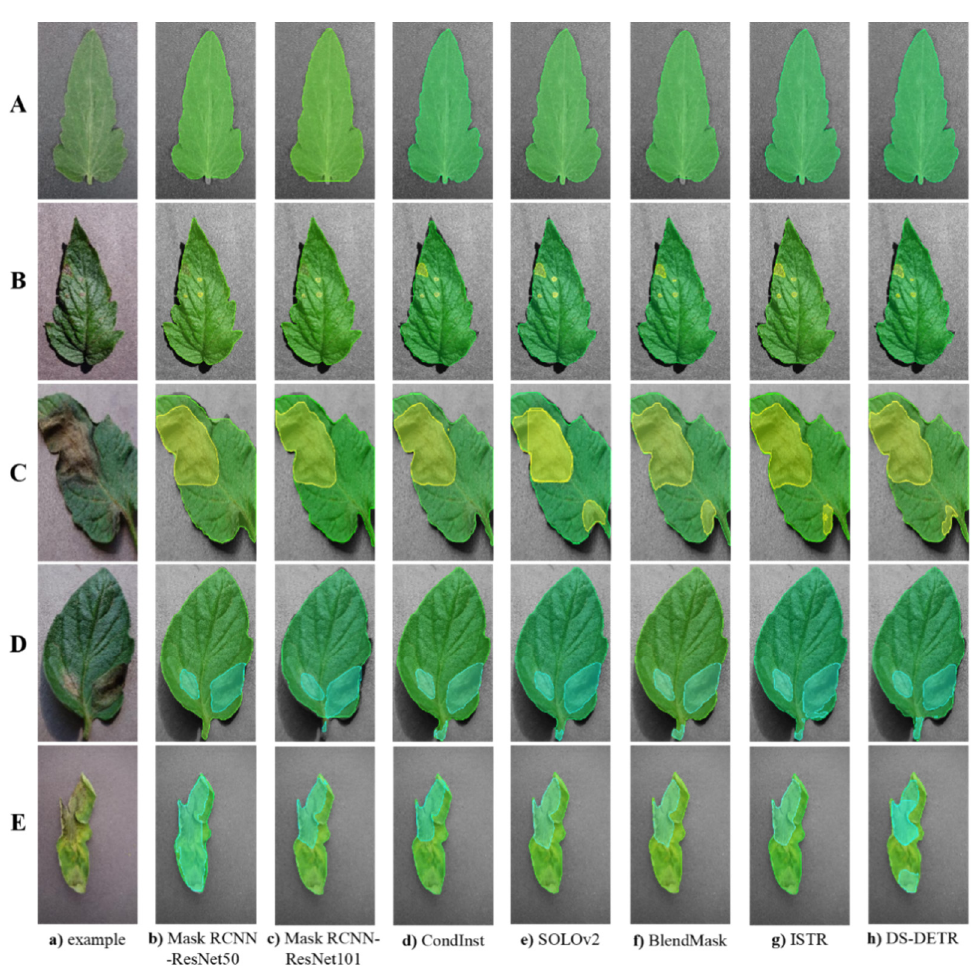
Figure 7. Segmentation effect visualization results. ( A – E ) are used to represent the grouping index numbers of the five samples we selected and their results respectively. Table 2. Average precision bounding boxes (AP box ), average precision segmentation (AP mask ), runtime per image, and model parameter of instance segmentation in tomato disease spot and leaf.